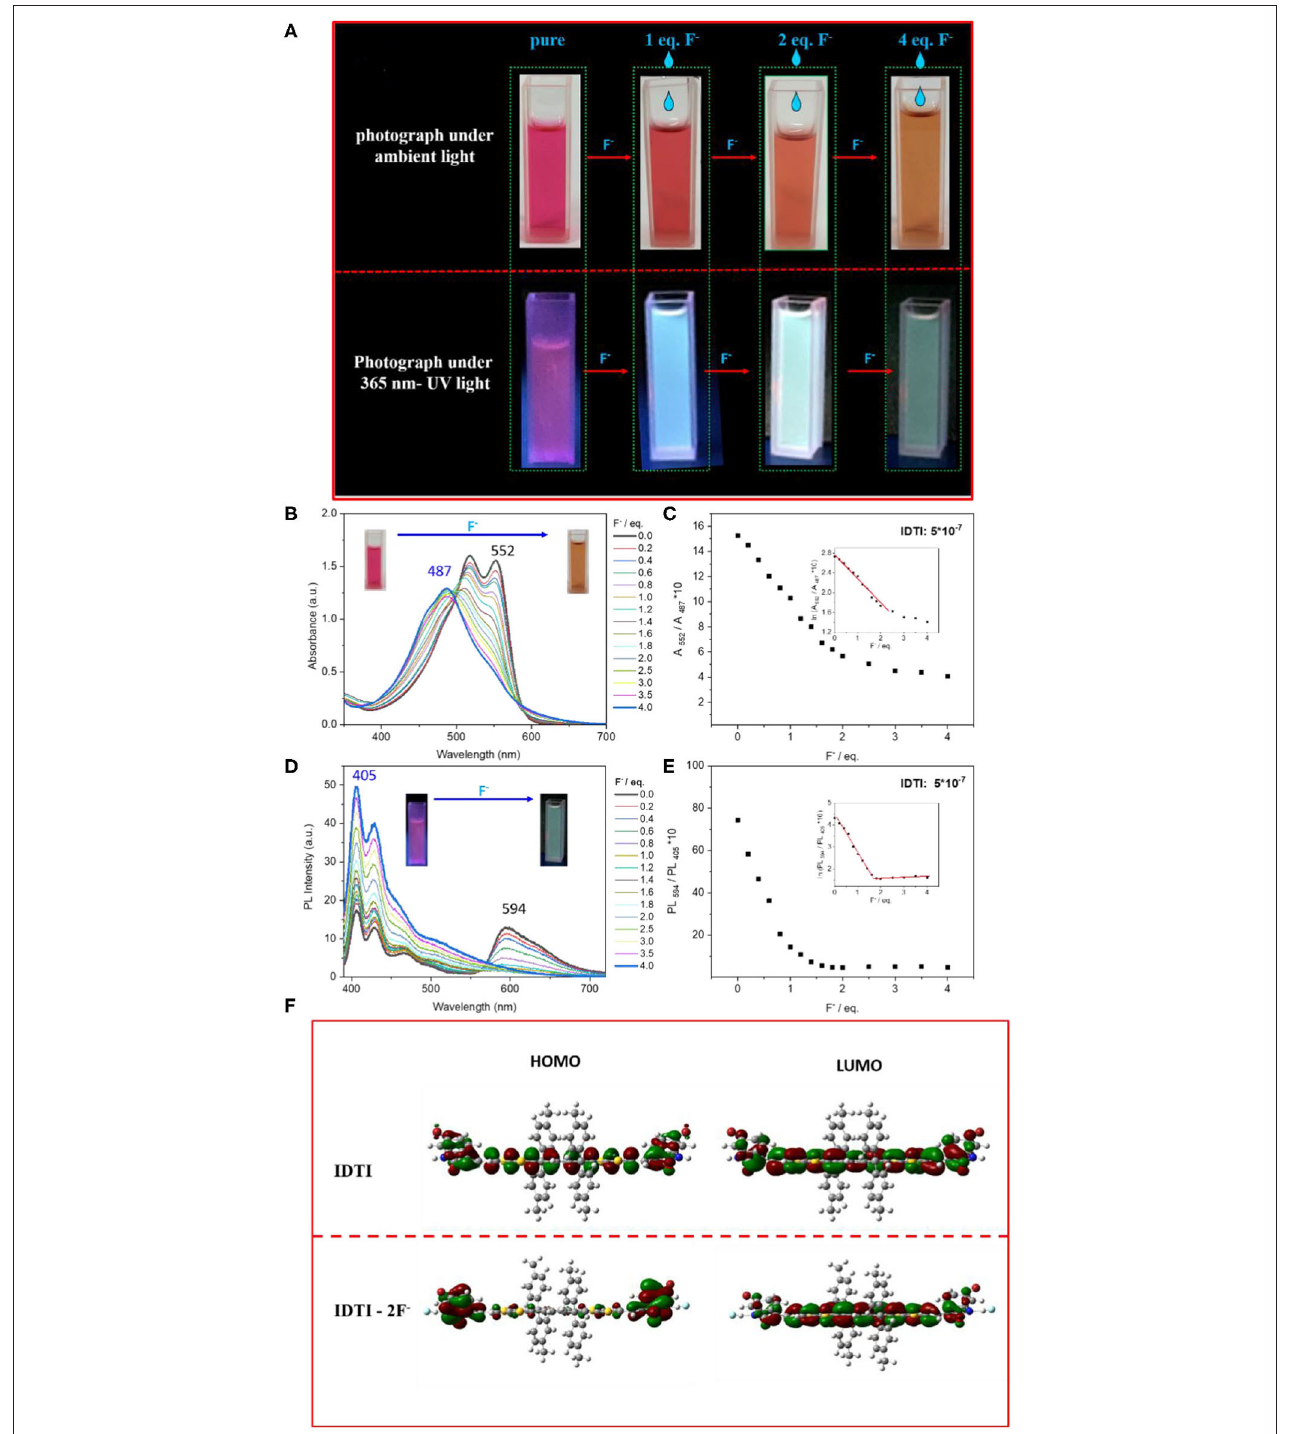
FIGURE 1 | (A) Photograph of the IDTI solution with or without additional different eq. fluoride anion under ambient light or 365nm UV light. (B,D) UV/Vis absorption (B) and PL fluorescence spectra (D) of IDTI (5.0 × 10 − 7 M) in the presence of F − (0–4.0 eq.) in tetrahydrofuran (THF). (C,E) Ten times the absorption intensity ratio of IDTI (5 × 10 − 6 M after mixing with F − in THF) between 552 and 487nm (A 552 /A 487 nm) vs. fluoride anion concentration (C) and the PL fluorescence intensity ratio of IDTI (5 × 10 − 6 M after mixing with F − in THF) between 594 and 405nm (PL 594 /PL 405 nm) (E) vs. fluoride anion concentration. The inset is the natural logarithm of 10 times the absorption intensity ratio A 552 /A 487 nm and PL 594 /PL 405 nm vs. fluoride anion concentration, respectively. (F) Molecular orbital surfaces of the highest occupied molecular orbital (HOMO) and lowest unoccupied molecular orbital (LUMO) energy levels of IDTI and IDTI-2F − obtained at the B3LYP/6-31G* level.